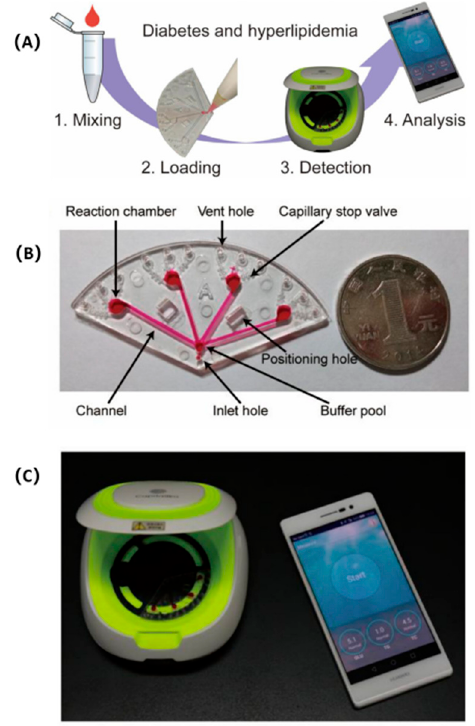
Figure 9. The process of the microfluidic chemical analyzer for analyzing diabetes and hyperlipidemia. ( A ) The process has four steps. First, the serum sample is mixed with a reagent. Second, the mixed solution is injected at the entrance of the microfluidic chip. Third, the detector is used for detection and analysis. Finally, the mobile phone is used to read the data. ( B ) Schematic of a microfluidic chip for multi-index analysis. ( C ) A microfluidic chemical analyzer assisted by a smartphone was used to analyze the color changes of two reagents in the chip reaction chamber. Reprinted with permission from [190]. Copyright 2019 Elsevier. Table 6. The overview of applications of microfluidic POC devices in the early diagnosis of chronic diseases.